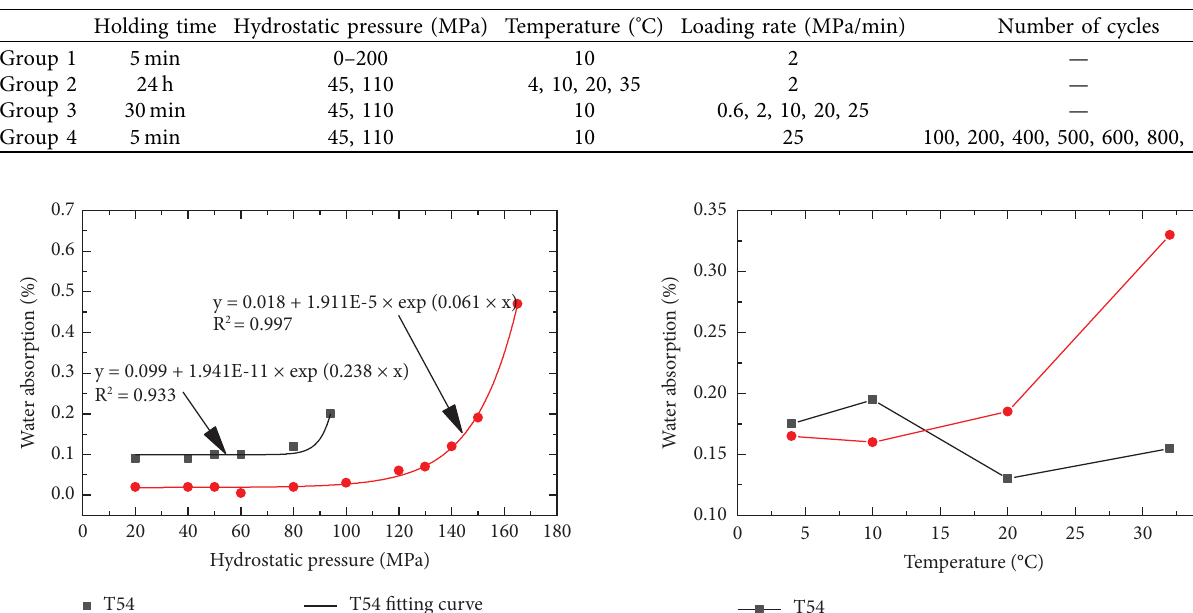
Table 2: Experimental parameters.